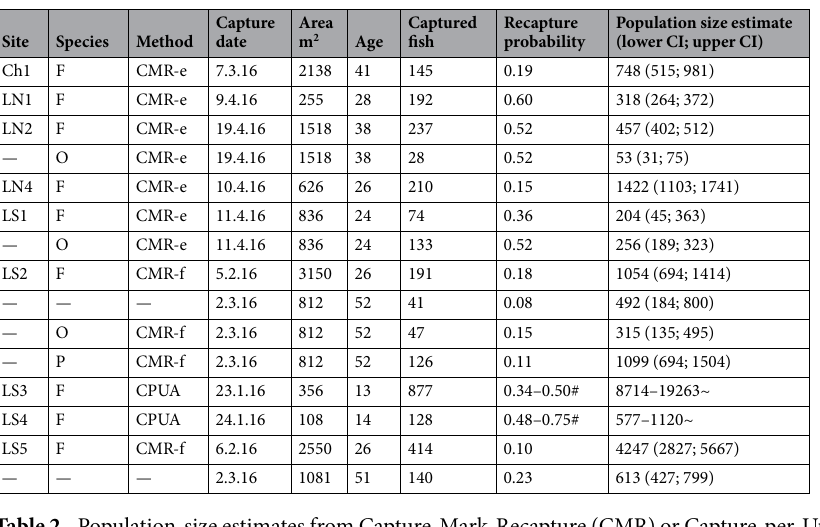
Table 2. Population-size estimates from Capture-Mark-Recapture (CMR) or Capture-per-Unit-Area depletion (CPUA) method. In the CMR, adult fish were marked with either visible implant elastomer tags (CMR-e) or by